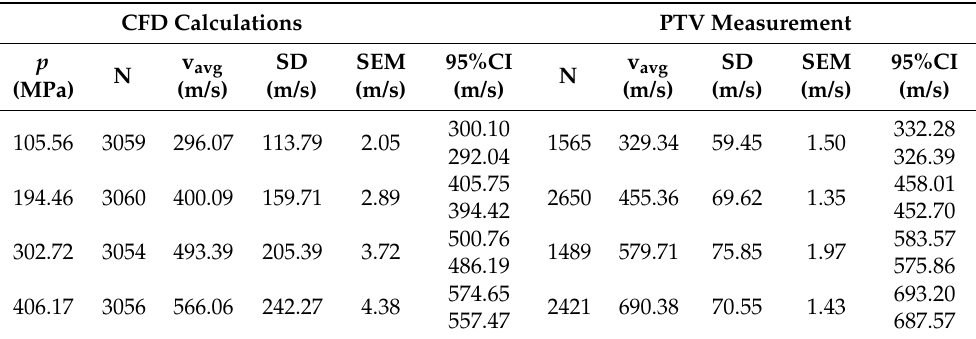
Table 2. Comparison of the average values of abrasive particle velocities from CFD calculations and PTV measurement for an abrasive mass flow rate of 100 g/min.